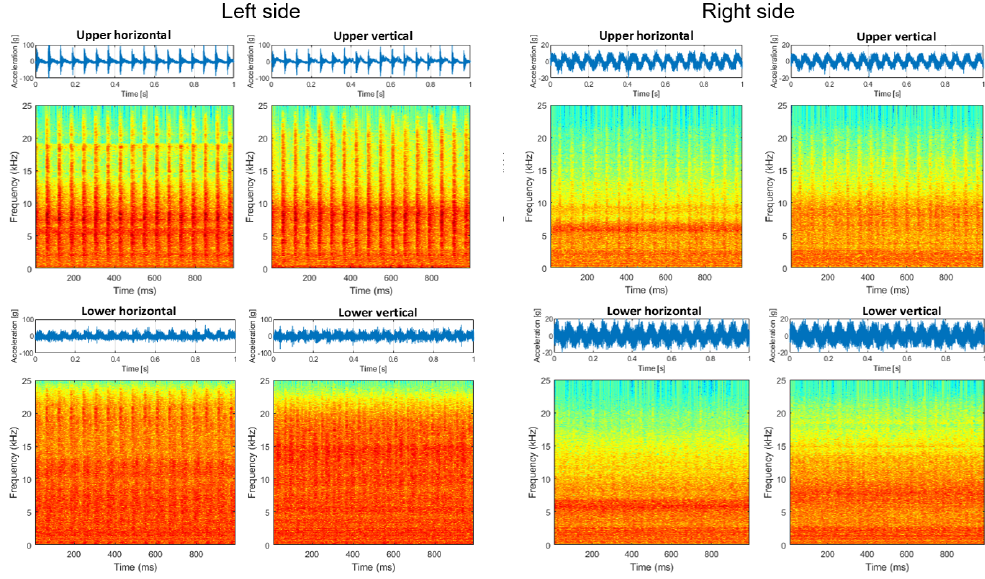
Figure 8. Signals and spectrograms before repair.